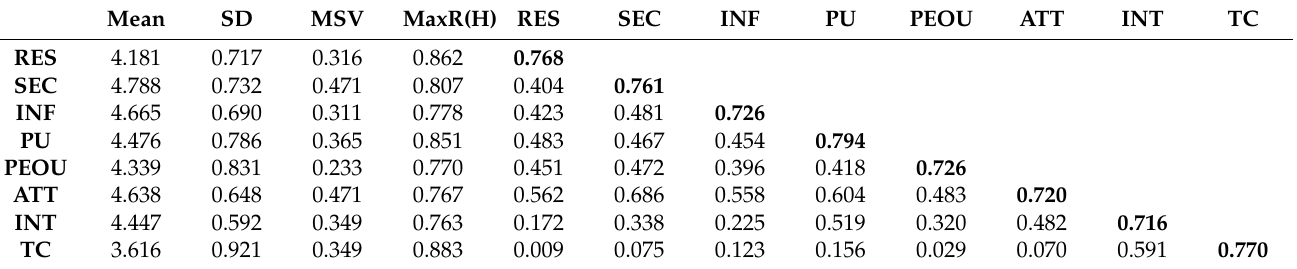
Table 3. Descriptive statistics and discriminant